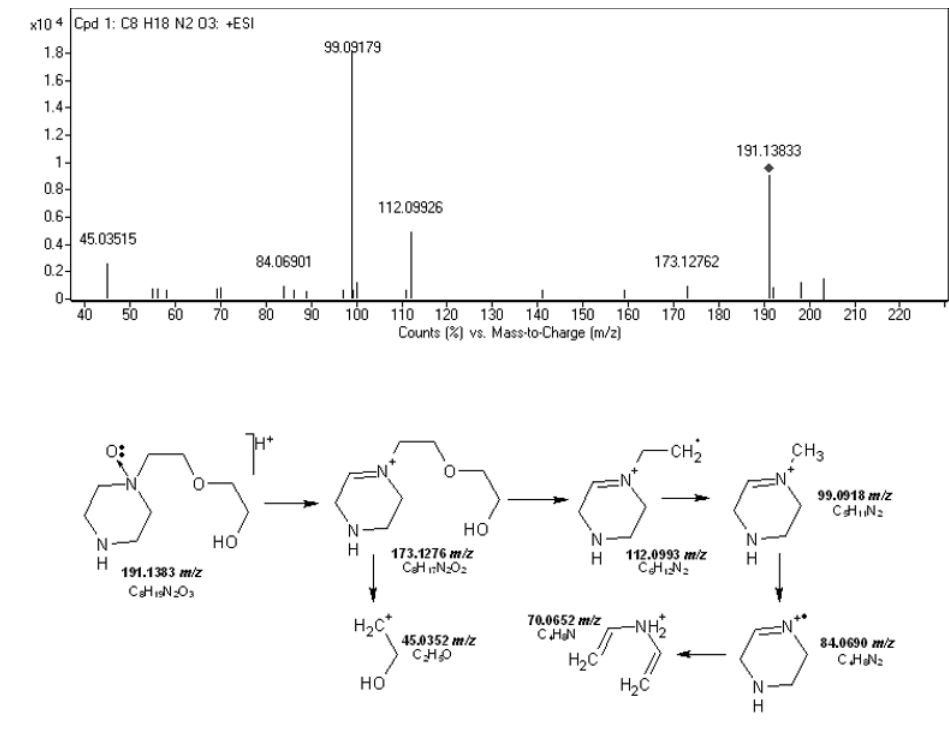
Figure 7. Q-TOF MS/MS spectrum and fragmentation pathway of photodegradation product D5 ( t